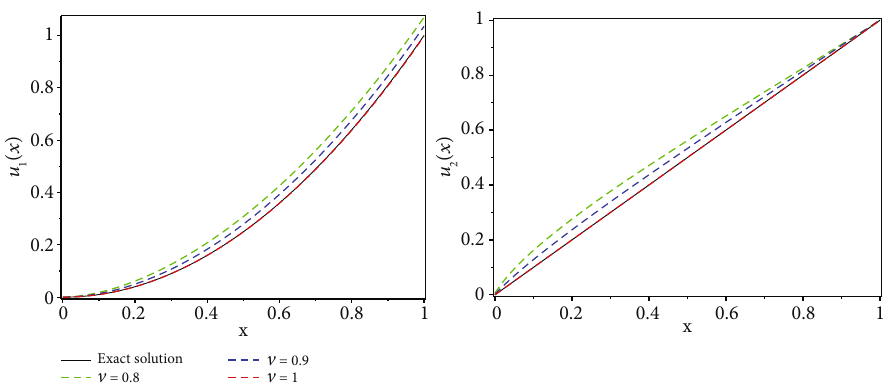
= 0 : 8,0 : 9,1, i = 1, 2 in Example 1. : ν i i